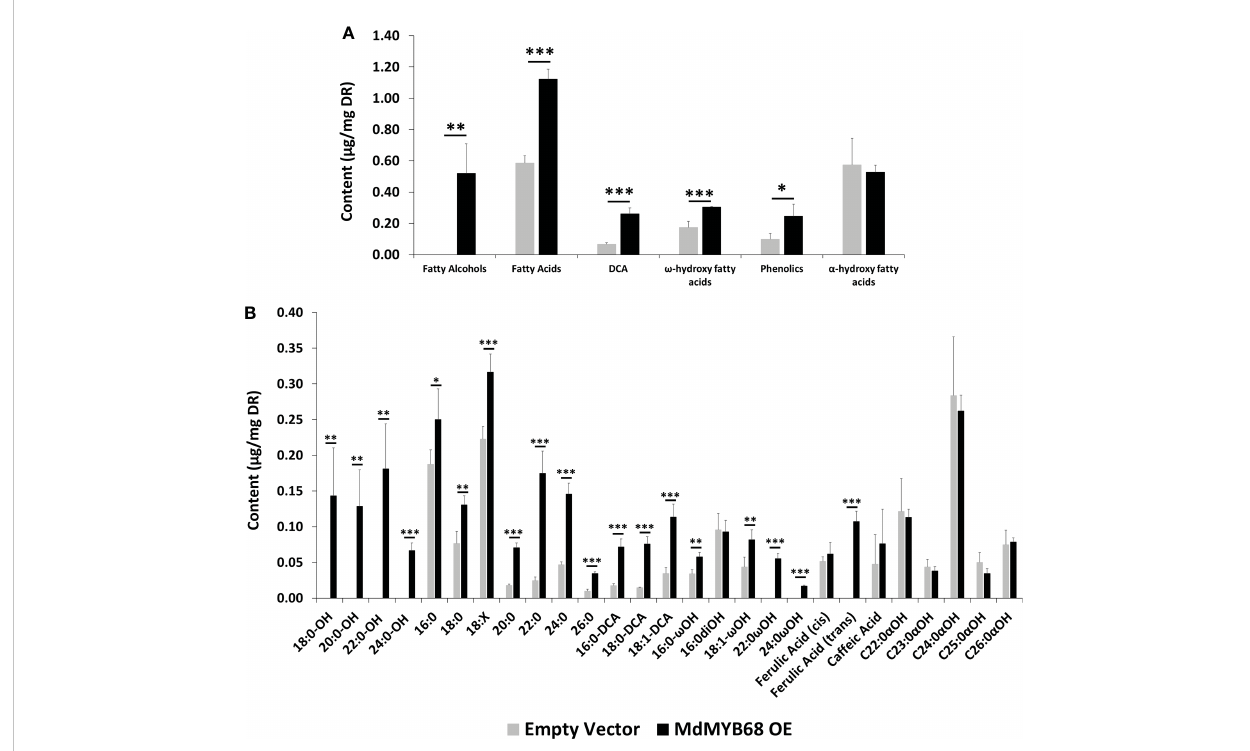
FIGURE 6 GC-MS analysis performed from the trans-esteri fi ed lipid fraction obtained from Nicotiana benthamiana leaves samples collected 7 days after agroin fi ltration with the MdMYB68 construct (MdMYB68 OE) or the Control/empty vector construct (Empty vector). 4 biological replicates were used (n=4). (A) content gathered by lipid subclasses, (B) fatty acids, fatty alcohols, w - and a -hydroxy fatty acids, ferulic acid, sterols, and waxes. Values are expressed as the mean ± SD from four biological replicates. One, two and three asterisks indicate signi fi cant differences at p < 0.05, p < 0.01, p < 0.001,